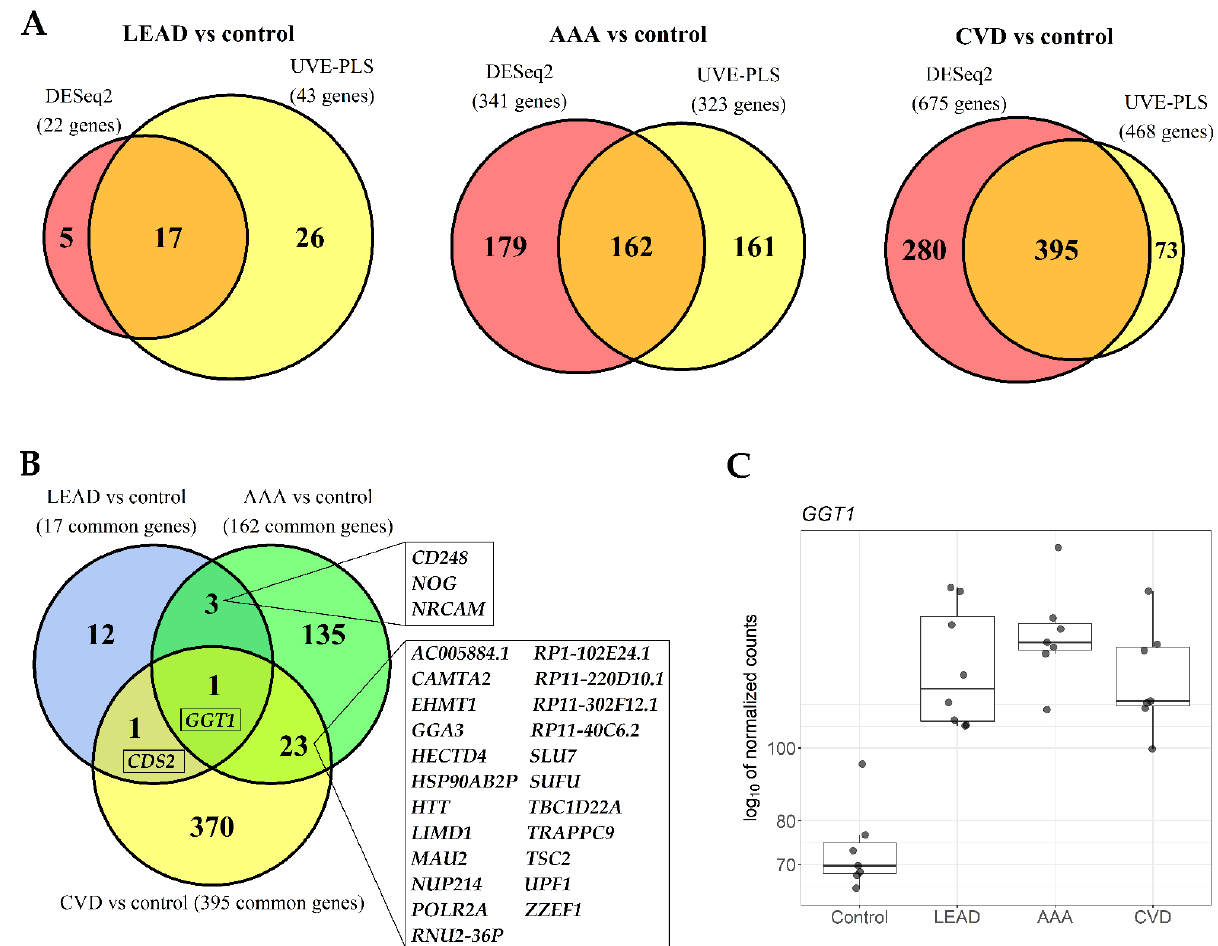
Figure 1. The comparison of differentially expressed genes in lower extremities arterial disease (LEAD), abdominal aortic aneurysm (AAA) and chronic venous disease (CVD) in relation to healthy controls. ( A ) The comparisons of differentially expressed genes in LEAD vs. control, AAA vs. control and CVD vs. control comparisons. Genes were obtained using DESeq2 and UVE-PLS methods and unified selection criteria ( p value adjusted by Benjamini–Hochberg false discovery rate <0.001 and reliability score ≥8, respectively). The numbers in the middle fields in each Venn diagram represent the amount of genes common for both methods. ( B ) The comparison of the genes common for DESeq2 and UVE-PLS methods from the Venn diagrams on panel A. The rectangles present gene symbols located in the corresponding fields of the Venn diagram. ( C ) Boxplot for the log10 of normalized counts of GGT1 , which was found as a common gene on the Venn diagram from panel B. Whiskers define range between minimum and maximum value, boxes range between 25% and 75% quartile, horizontal lines inside boxes mark median value. UVE-PLS-Uninformative Variable Elimination by Partial Least Squares.